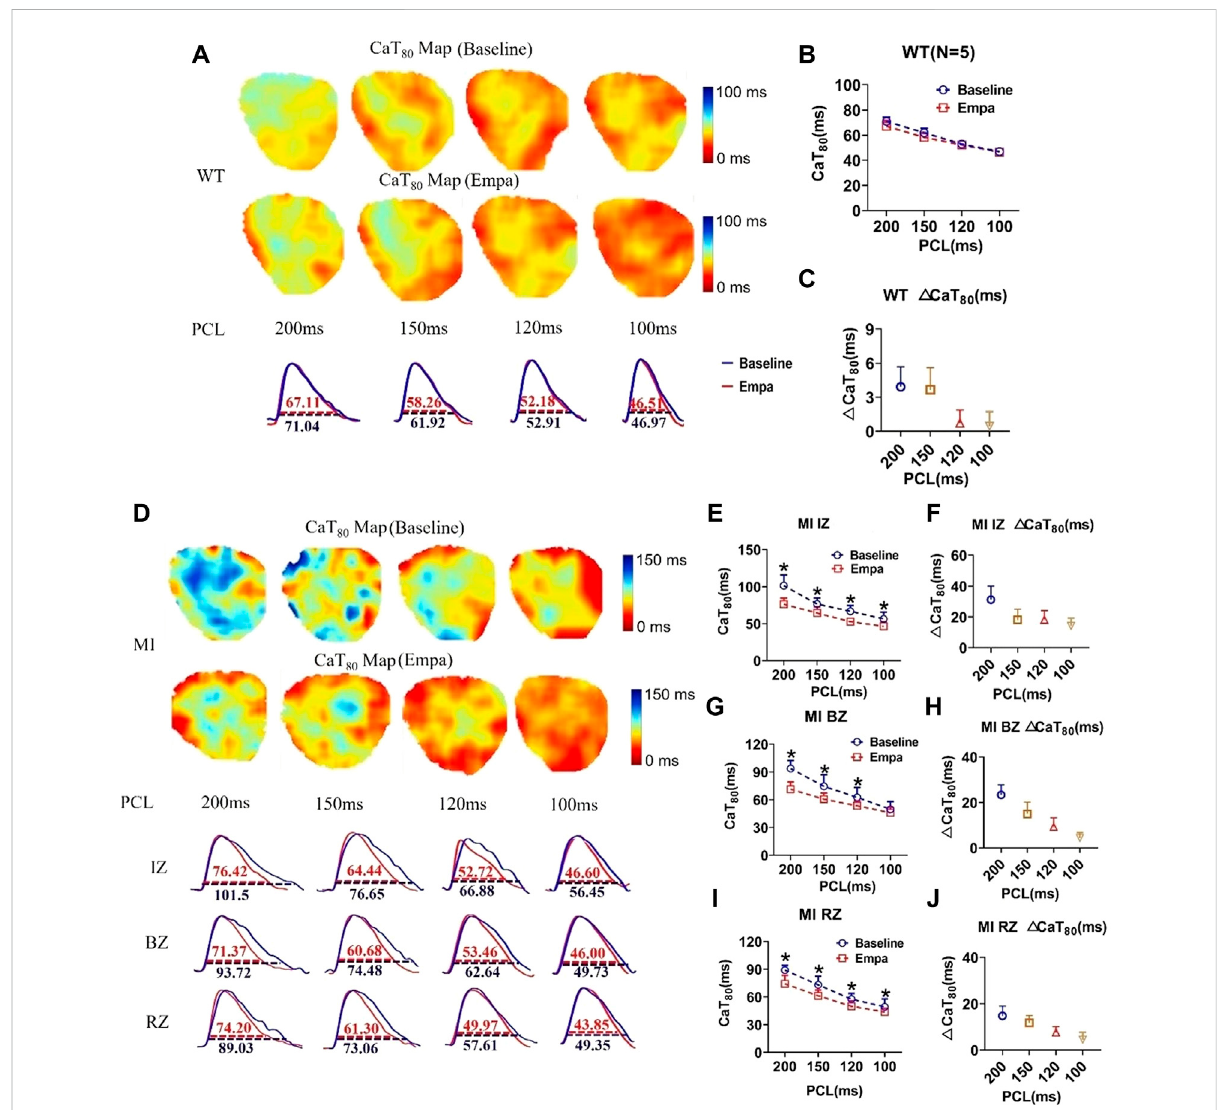
FIGURE 4 Effects of EMPA on Ca 2+ transient duration (CaTD) atdifferentpacing cycle lengths (PCLs) in normal and infarcted ventricles. (A) Representative Ca 2+ transient traces and CaT at 80% repolarization (CaT 80 ) maps at baseline and in the presence of EMPA (10 umol/L) in normal ventricles. (B,C) CaT 80 and Δ CaT 80 associated with different PCLs at baseline and after EMPA infusion in normal ventricles. N = 5. (D) Representative Ca 2+ transient traces and CaT 80 maps atbaselineand in the presence of EMPA ininfarcted ventricles of IZ,BZ, and RZ. (E,F) CaT 80 and Δ CaT 80 associated with different PCLs at baseline and after EMPA infusion in infarcted ventricles of IZ. N = 9. * p < 0.05 vs . baseline, p -values were determined by unpaired t test. (G,H)